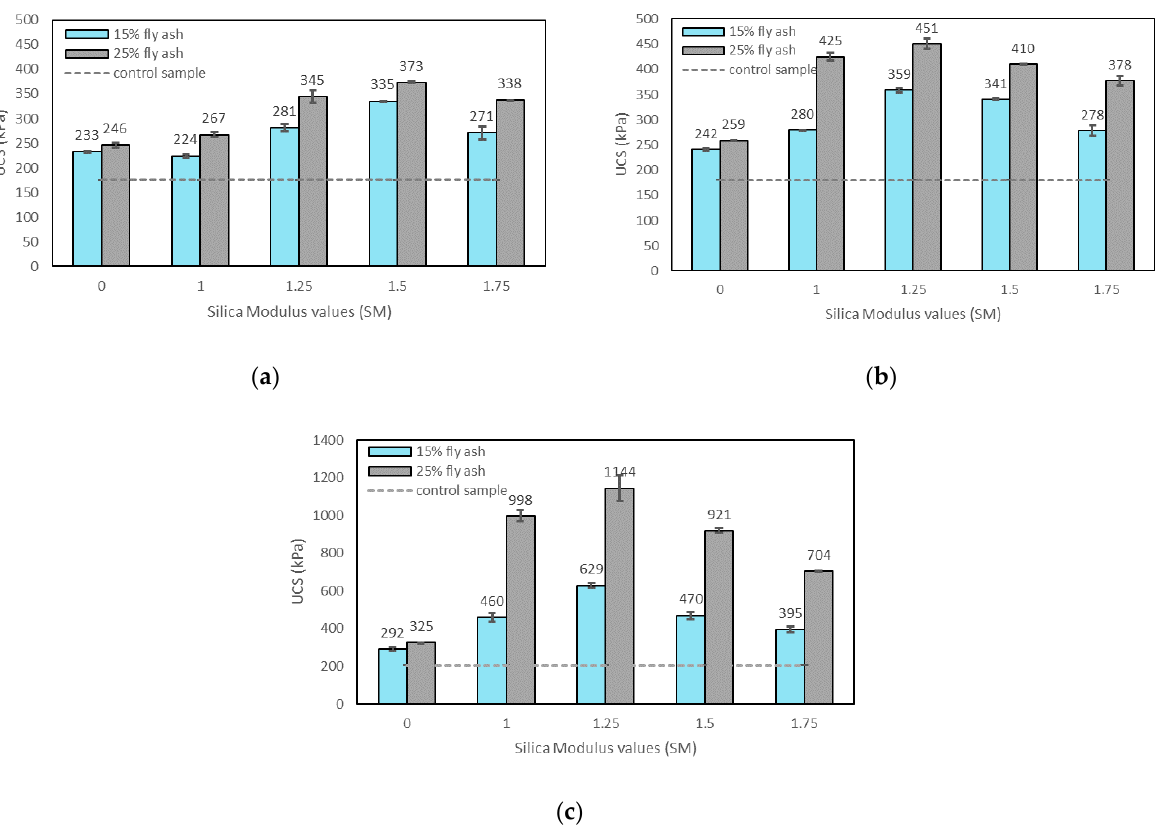
Figure 6. Effects of silica modulus on the UCS of control sample, soils stabilised with fly ash, and soils stabilised with alkali-activated fly ash with an M+ of 12% at ( a ) 1 day of curing; ( b ) 7 days of curing; ( c ) 28 days of curing.